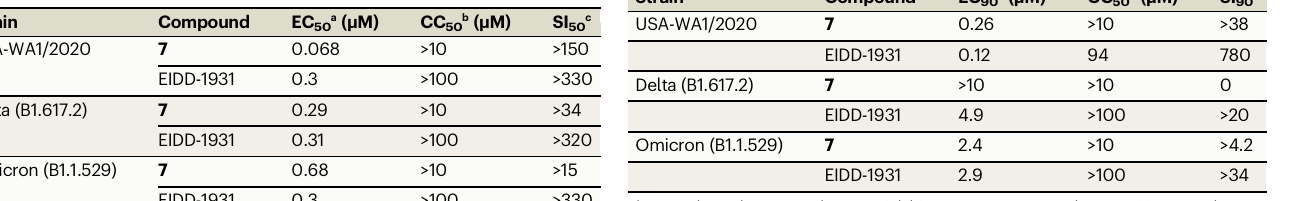
Table 2 | Cytopathic effect of compound 7 against three var- iants of SARS-CoV-2 in Vero E6 cells in the presence of 2 μ M CP-100356 Strain